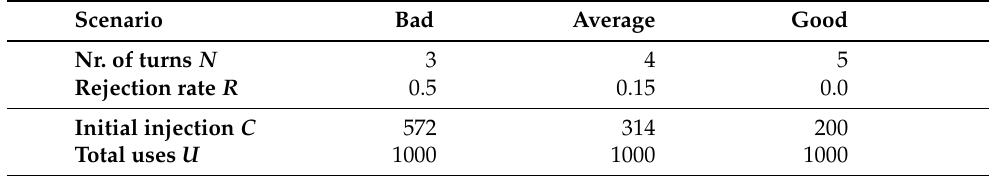
Table 8. The initial injection C of virgin catheters needed to prime a buy-back scheme system . Results are calculated with Equation (5) for the three scenarios described in Table